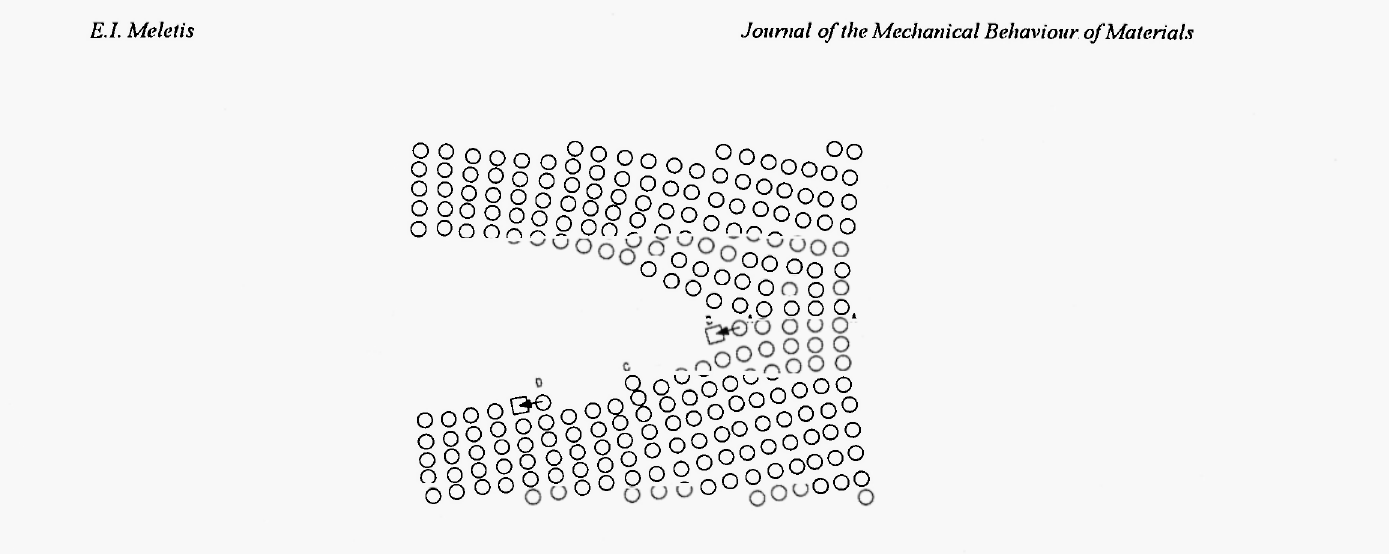
Fig. 6 Events involved in the surface mobility mechanism. Vacancy injection at the